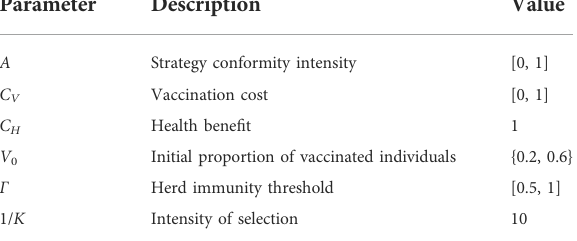
TABLE 1 Summary of